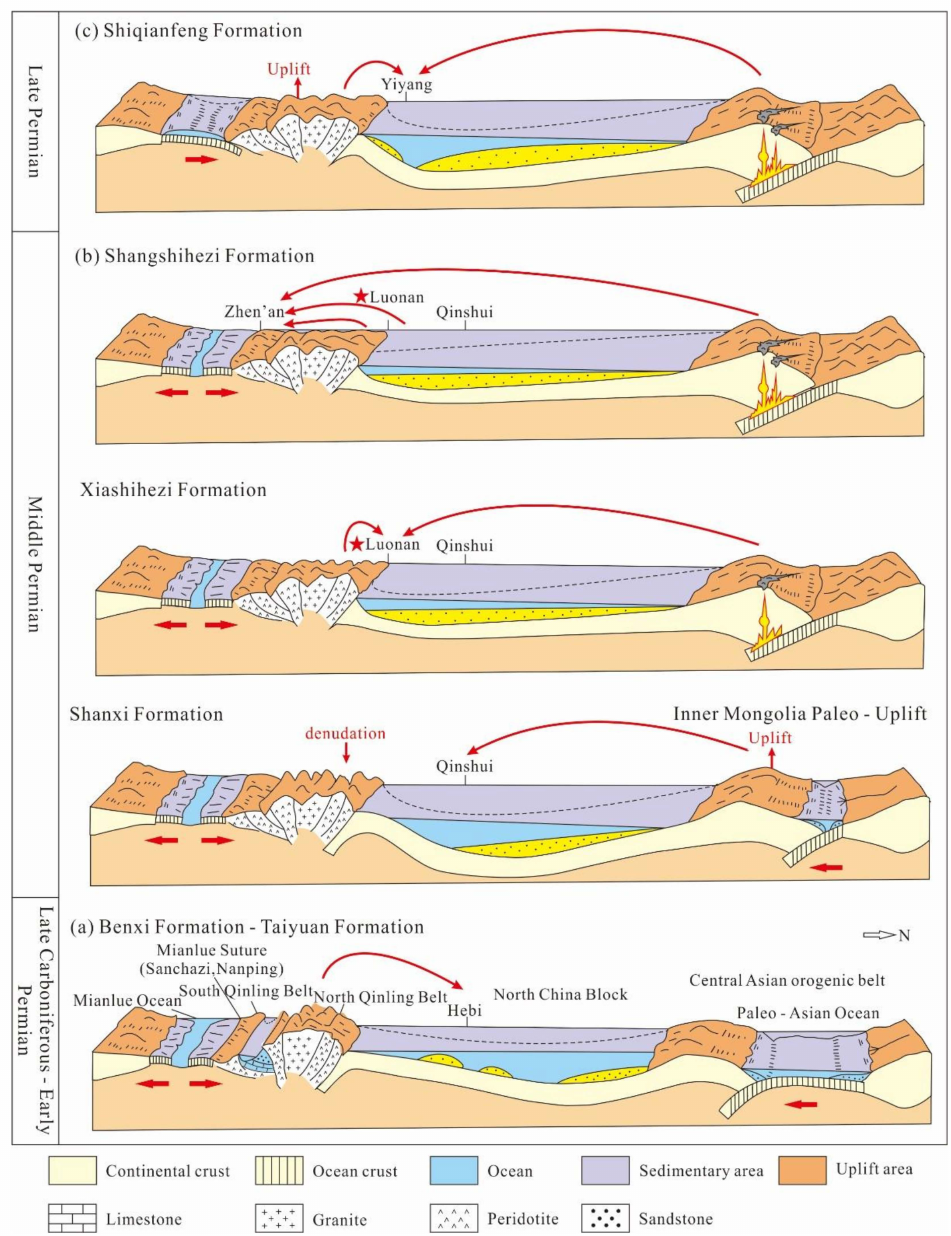
Figure 6. Late Carboniferous–Late Permian tectonic evolution in North China Block based on provenances. ( a ) The subduction stage of Paleo-Asian Ocean and the expansion stage of Mianlue Ocean; ( b ) the subduction-closure stage of Paleo-Asian Ocean; ( c ) initiation of the Mianlue Ocean